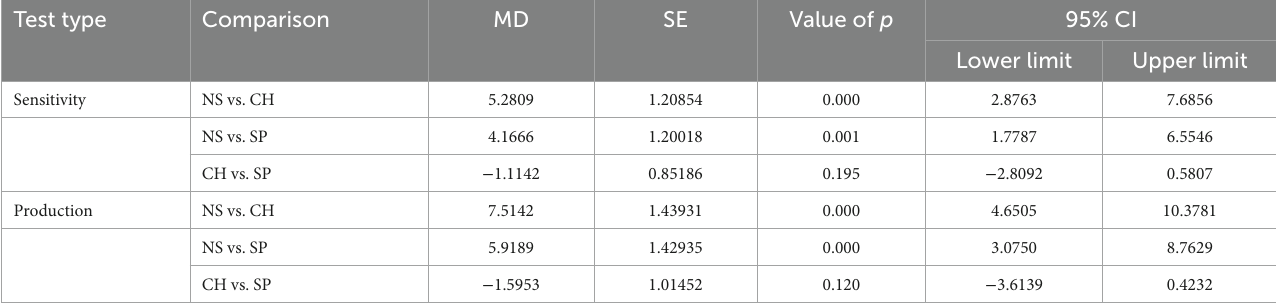
TABLE 2 Results of between-group multiple comparisons with LSD